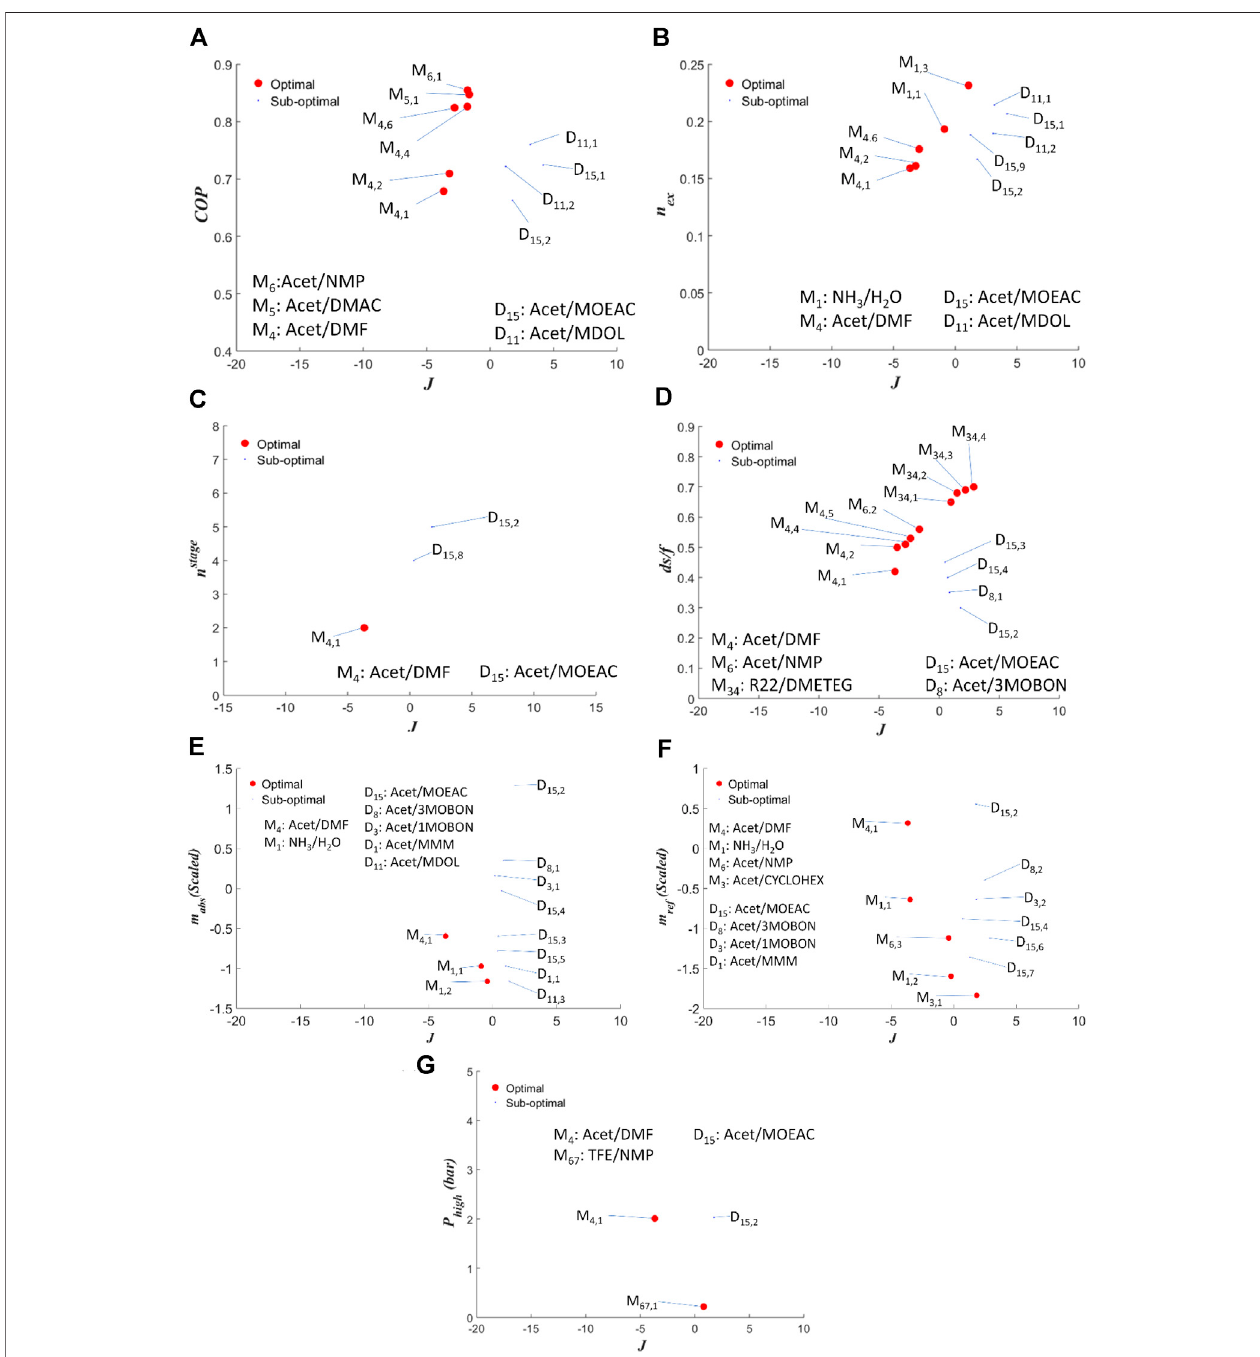
FIGURE5| Paretofrontsof (A) COP , (B) n Ex , (C) n stage , (D) ds / f , (E) m abs , (F) m ref , (G) P high , vs.index J, comparing theperformanceofthedesignedmixtures( “ D ” ) with the best ones obtained from (Papadopoulos et al., 2020b) ( “ M ”